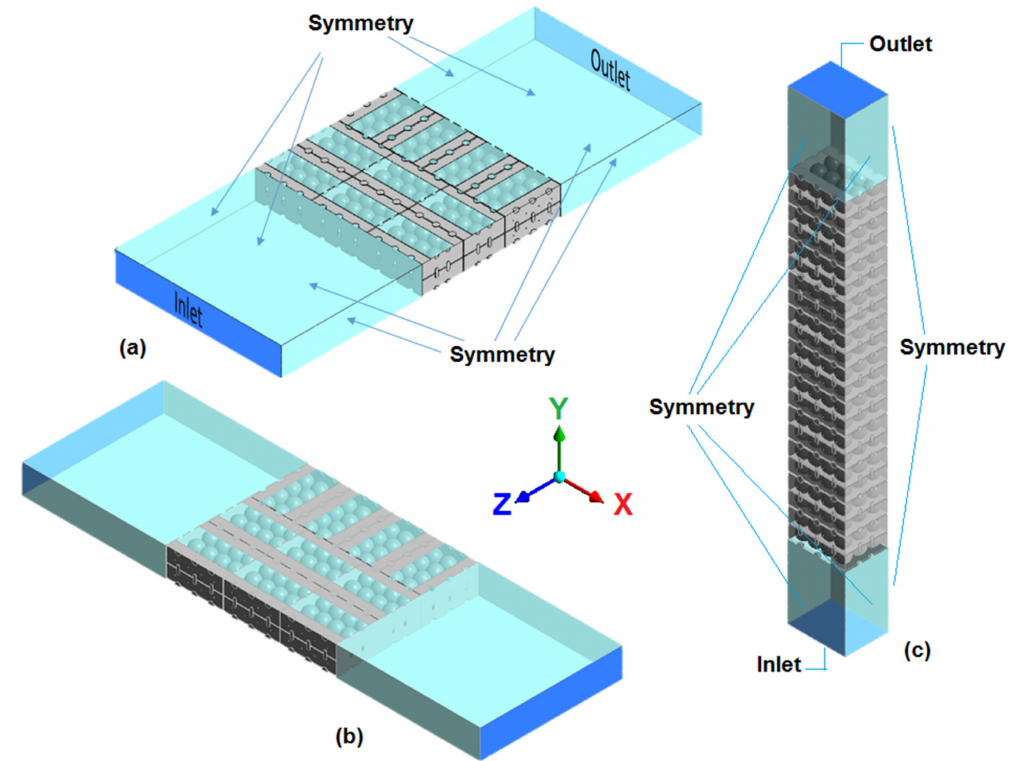
Figure 8. Illustration of the geometry of produce-cooling configurations. ( a ) a layer with its long side perpendicular to the horizontal airflow direction, ( b ) a layer with its short side perpendicular to the horizontal airflow direction, both mimicking precooling and room-cooling operations and ( c ) individual vertical column of stack along the vertical airflow direction, mimicking the cooling airflow in refrigerated